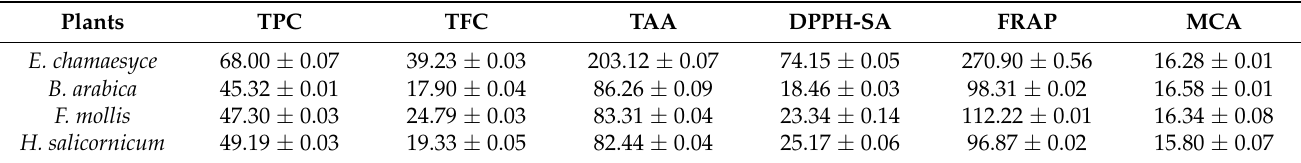
Table 1. Quantitative measurements of total phenolics, flavonoids, and antioxidant activity of the plant